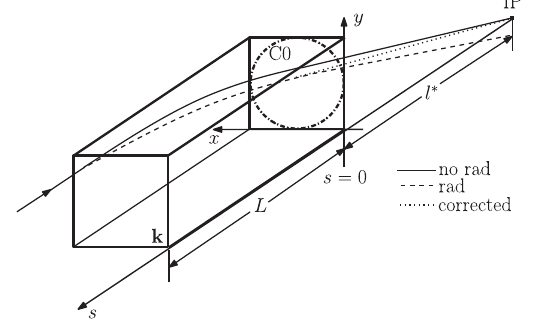
FIG. 7. The solid and dashed lines represent the particle trajectory without and with radiation, respectively. The dotted line represents the correction of the particle trajectory given by